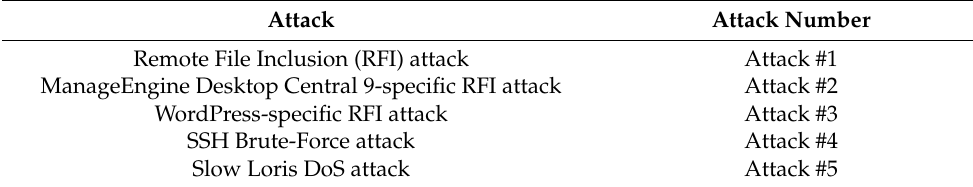
Table 1. Attack–attack Number Correlation.